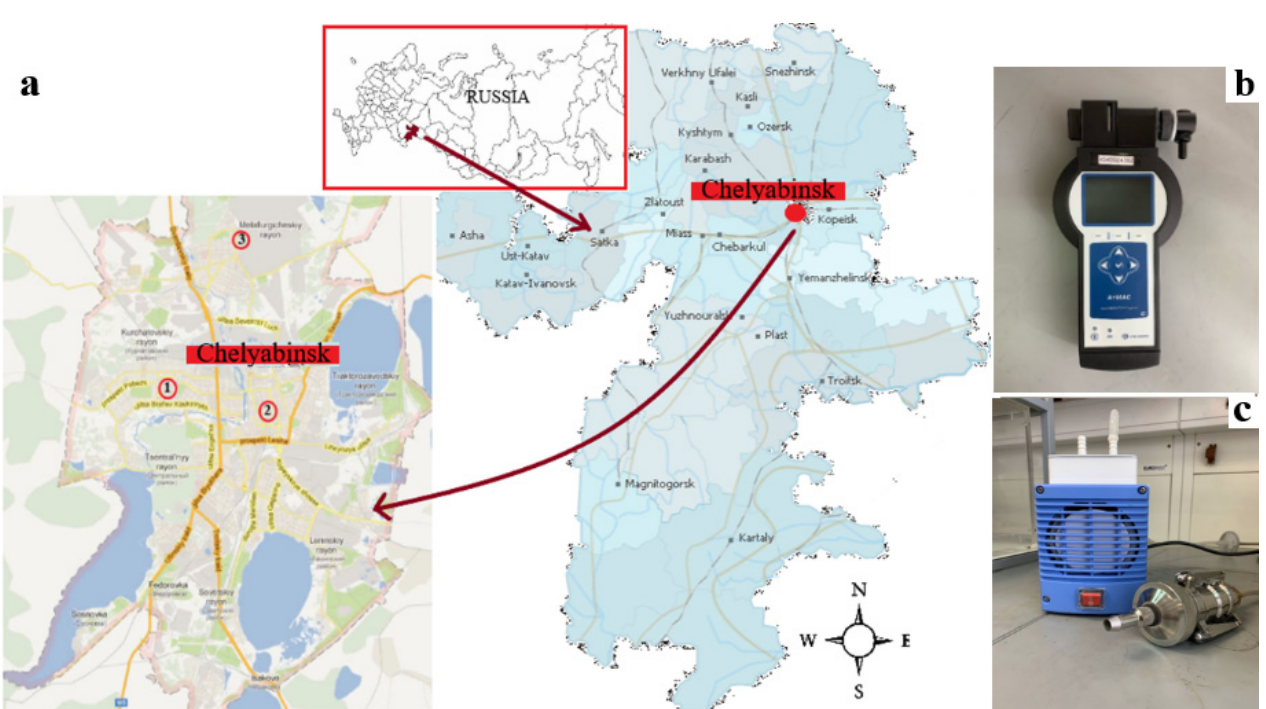
Figure 1. The area under study and the observation instruments used to record data. ( a ) Chelyabinsk (Russia) and the location of the three sampling stations. ( b ) Atmas (NTM Protection, Moscow, Russia) device, providing simultaneous measurement of the hourly data of PM 2.5 and PM 10 . ( c ). The aerosol cascade impactor sampler.